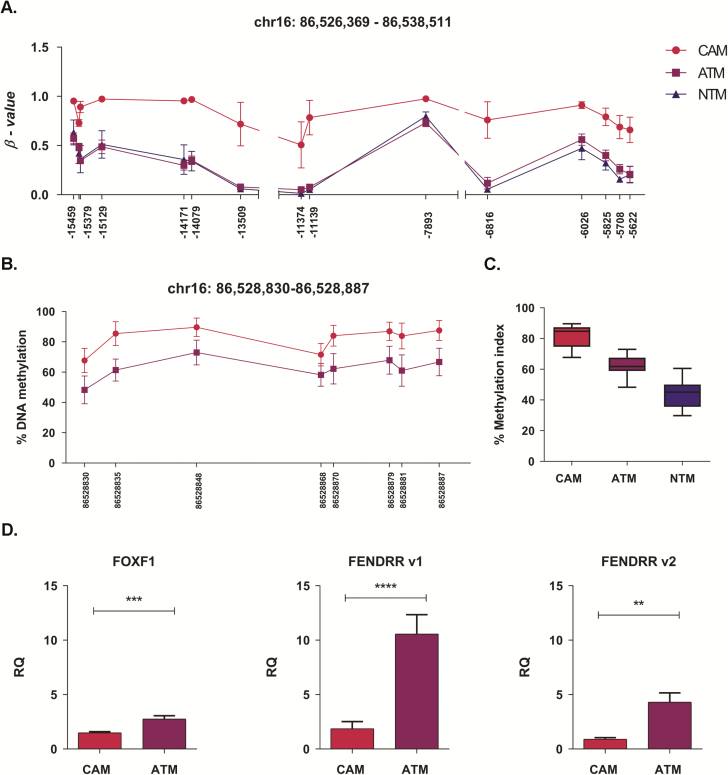
DNA methylation pattern in the genomic region associated with regulation of FOXF1 and FENDRR expression in gastric CAMs and ATMs. (A) Differentially methylated CpG sites identified by Illumina 450k array in the region downstream of the FOXF1 transcription start site. Mean β values (n = 3) for probes identified as differentially methylated in CAM versus ATM and CAM versus NTM comparisons are plotted. The x-axis indicates the distance of Illumina 450k probes to FOXF1 transcription start site. (B) Pyrosequencing analysis of the FOXF1 promoter region in patient-matched CAM (n = 7) and ATM (n = 7) samples. Methylation means for eight individual CpG sites in the interrogated promoter region are plotted. The x-axis indicates chromosomal position of examined CpG sites. (C) The overall methylation level of the FOXF1 promoter region interrogated by pyrosequencing assay. Boxplots represent methylation distribution and mean for eight CpG sites in CAM (n = 7), ATM (n = 7) and NTM (n = 4) samples. (D) Quantitative PCR analysis of FOXF1 and FENDRR gene expression in CAM and ATM samples; t test FOXF1 (n = 5) ***P = 0.0008; FENDRR, v1 (splice variant 1; n = 4) ****P < 0.0001; FENDRR, v2 (splice variant 2; n = 4) **P = 0.0028. Error bars represent standard error of mean.